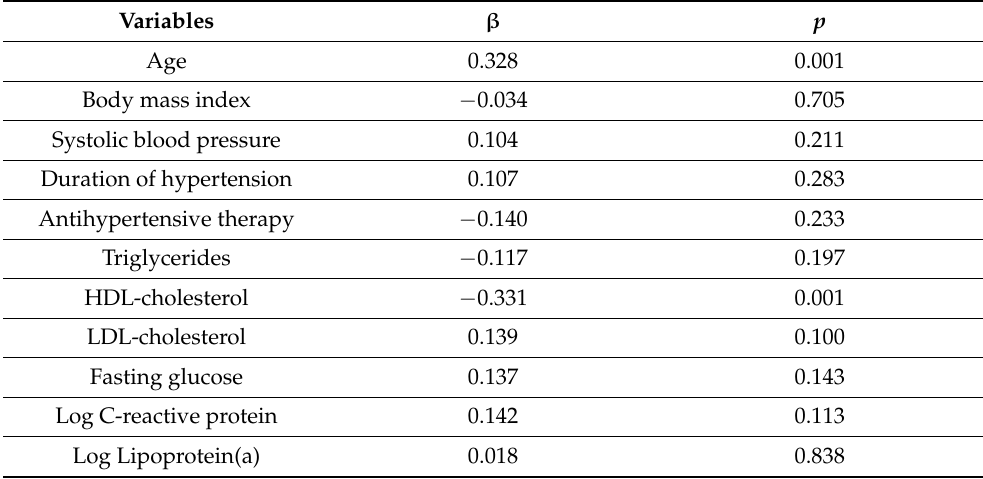
Table 4. Multivariate analysis with the pulse wave velocity as the dependent variable.